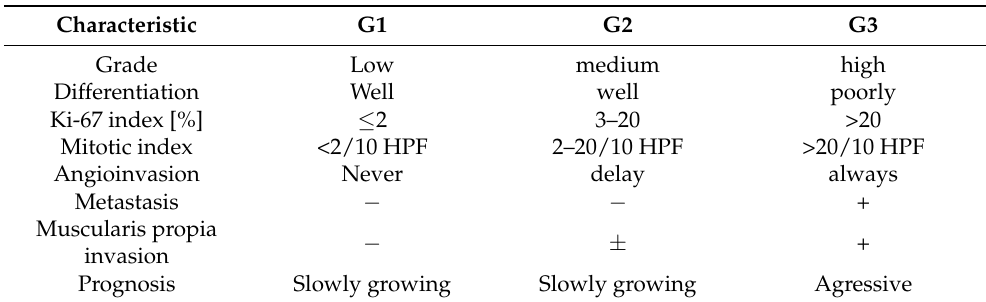
Table 1. Characteristics of NET subtypes based on WHO classification and prognostic factors based on